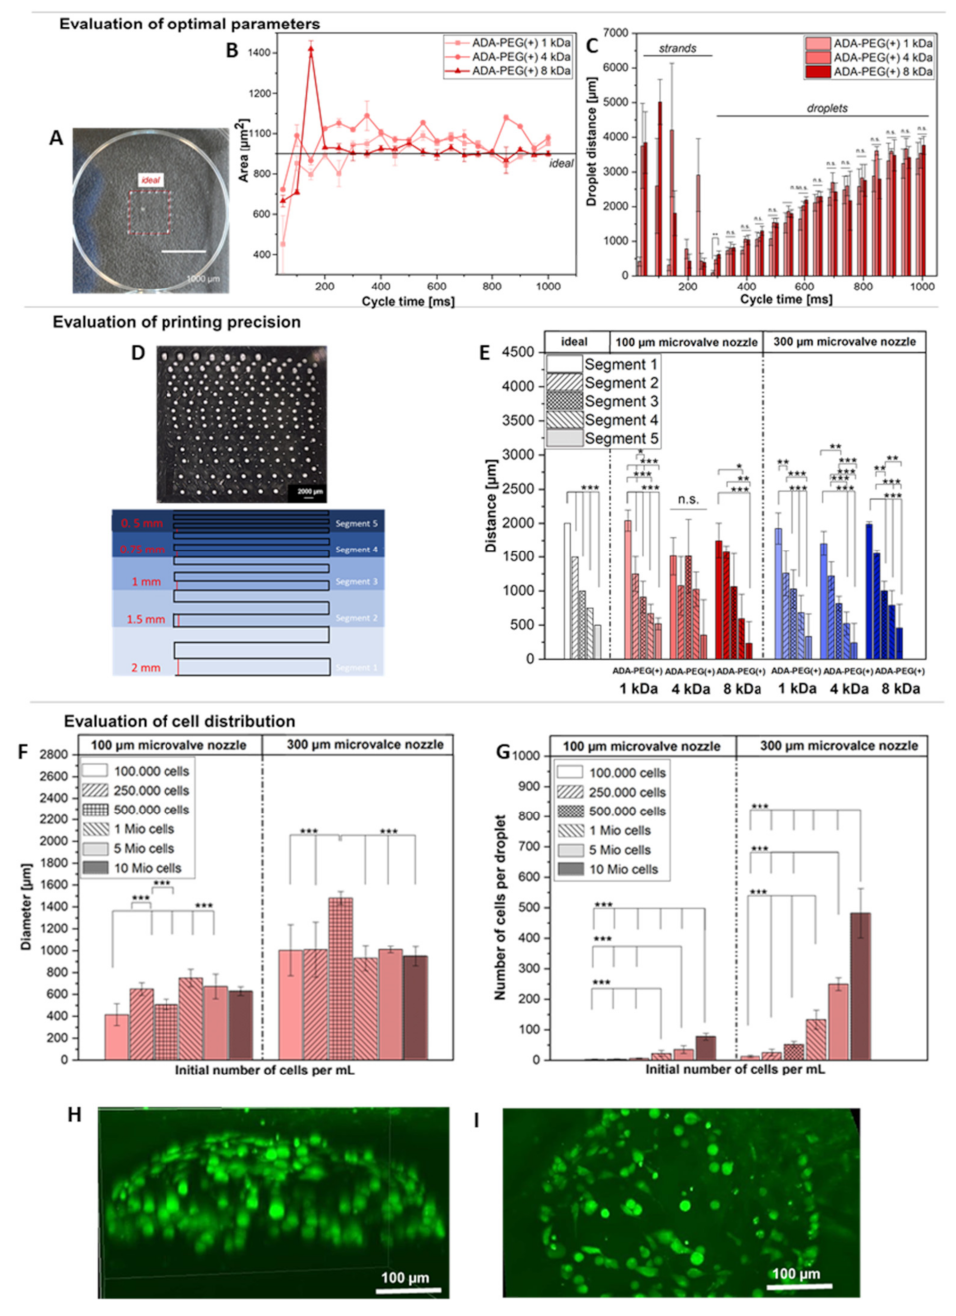
Figure 6. ( A ) Image of printed ADA-PEG(+) 1 kDa droplets using a square rectangle template with dimensions of 10 × 10 mm on PS with an added red square representing borders of the simulated ideal area. Scaffolds were printed using a 300 µ m microvalve nozzle ( n = 6); ( B ) influence of cycle time on the printing precision of a printed square shaped scaffold using ADA-PEG(+) 1, 4 and 8 kDa inks determined by the overlapping of the stimulated area with the printed one. Scaffolds were printed using a 300 µ m microvalve nozzle ( n = 6); ( C ) influence of the cycle time on droplet distances using ADA-PEG(+) 1, 4 and 8 kDa inks printed on PS. Scaffolds were printed using a 300 µ m microvalve nozzle ( n = 6); ( D ) illustration of the resolution tree for the filament fusion test showing segments 1–5 (bottom) and a light microscopy image of the printed version using ADA-PEG(+) 1 kDa on PS